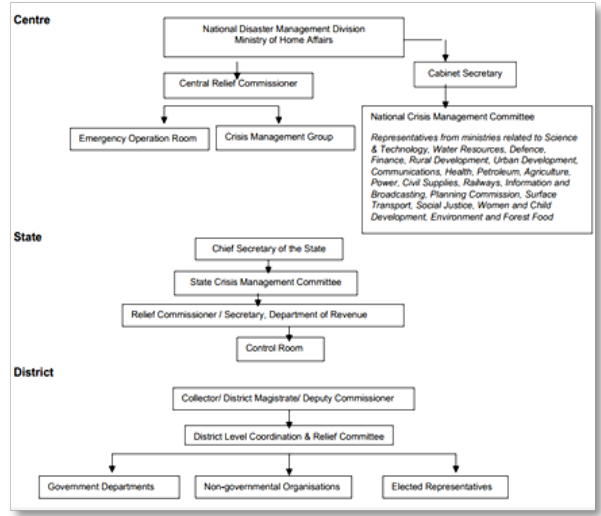
Figure 2: Institutional Structure for Disaster Management in India; (Source: Patwardhan et al,